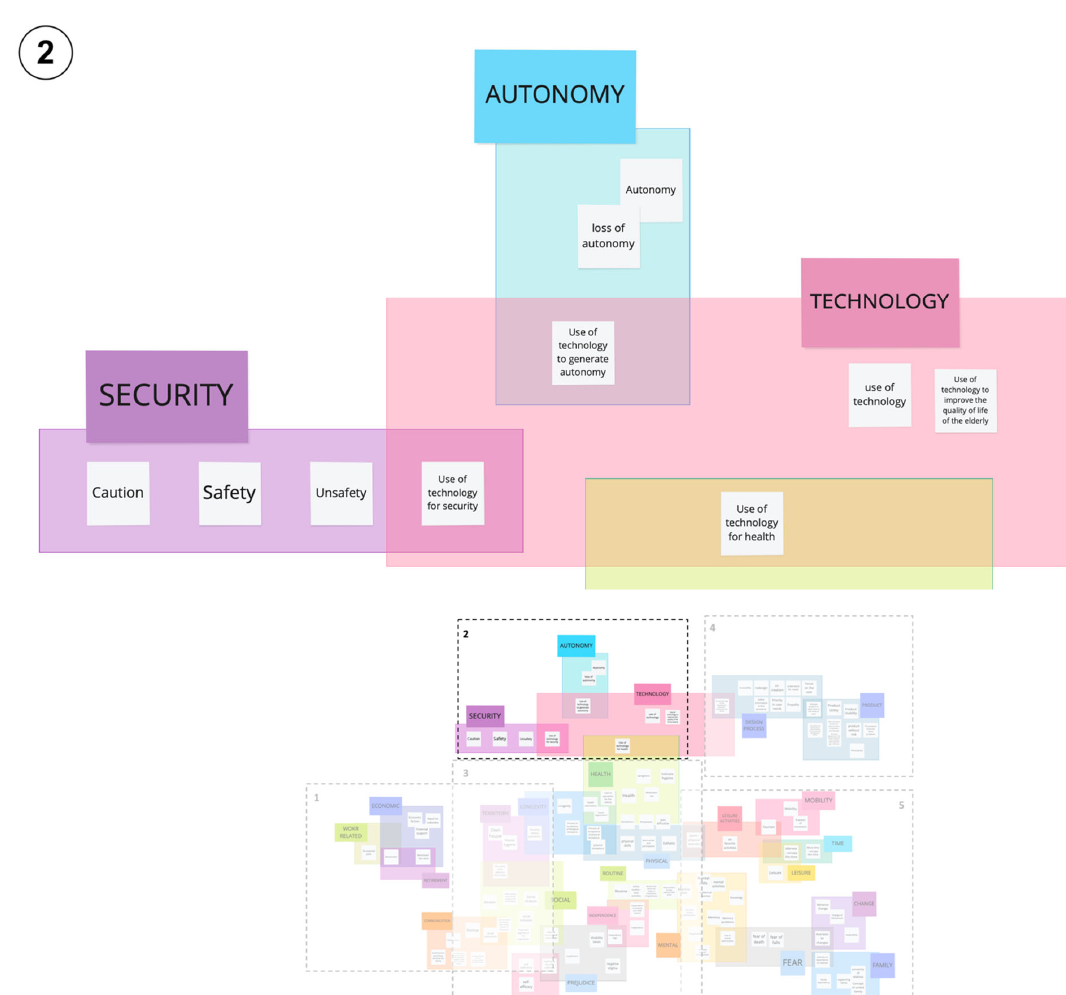
Figure A2. Map Section 2.